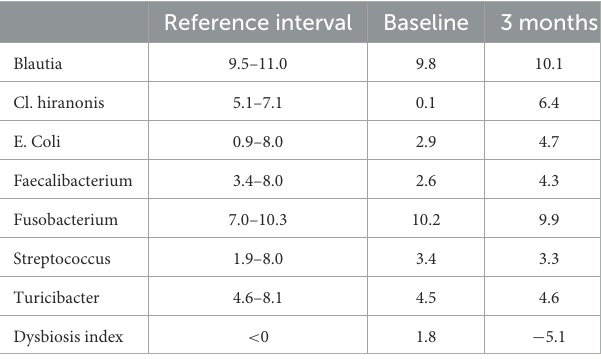
TABLE 2 Example results of change in the fecal microbiome in a single dog with